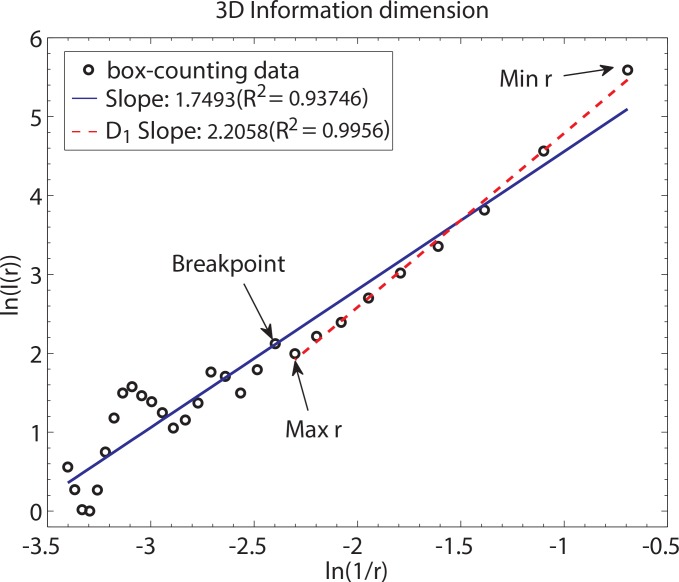
Computing fractal dimension using 3D information measure.Information dimension, D1, measure. In the scatterplot of log(1/r) versus log(I(r)), r is box size and I(r) is the information theoretic entropy for the box size r. Note. For information measure, the initial, pre-determined range of box sizes is r = 2… 30 voxels (in increments of 1 voxel). Data shown are for left hippocampus from one healthy control participant. Linear regression analysis is performed iteratively. Blue line indicates the linear fit over the entire range of r. Red dotted line indicates the final fit (R2); the slope of this line corresponds to the fractal dimension, D1. Breakpoint separates non-linear data points from the data used in the final regression analysis. ln denotes natural log. Min r is the new smallest box size and Max r is the new largest box size.